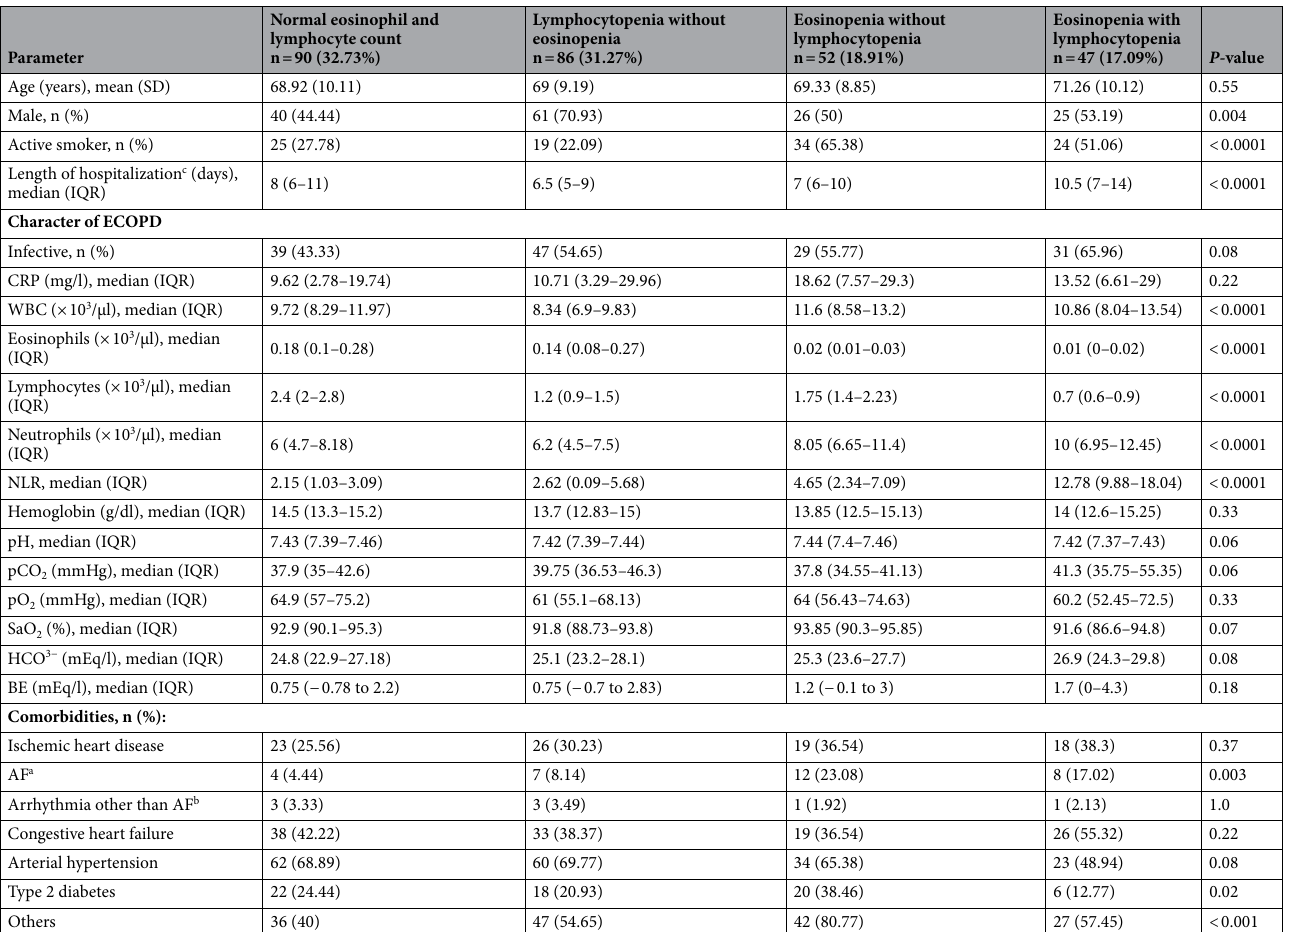
Table 4. Study parameters upon stratification by coexistence of eosinopenia and lymphocytopenia. AF atrial fibrillation, CRP c-reactive protein, IQR interquartile range, WBC white blood count. a First detected in the admission, paroxysmal, persistent or permanent. b In the admission or in the past medical history. c Among